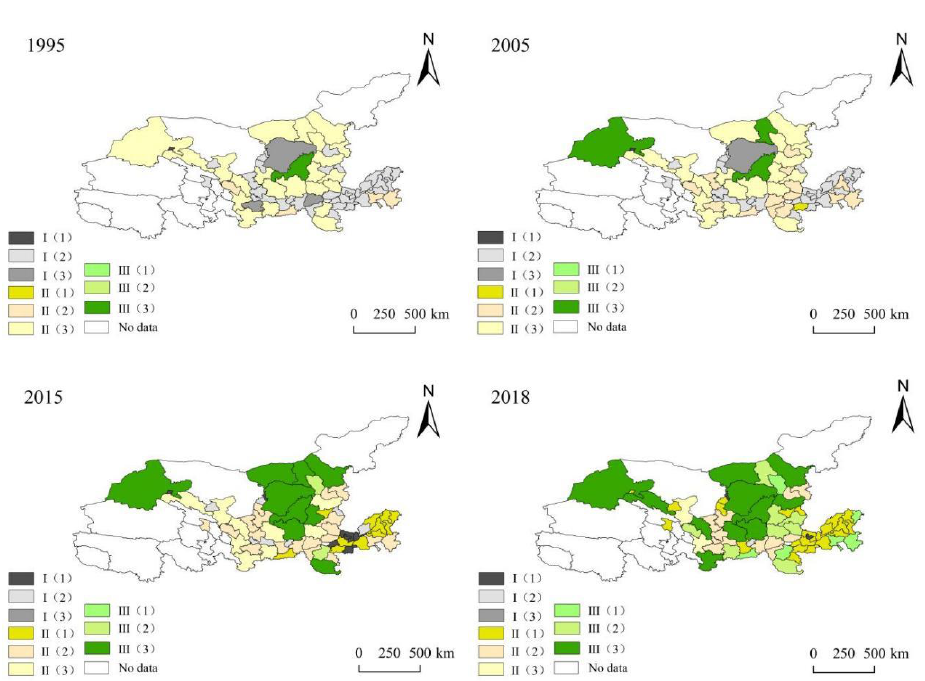
Figure 6. Spatio-temporal differentiation characteristics of urban coupling coordination degree in the Yellow River Basin, China.